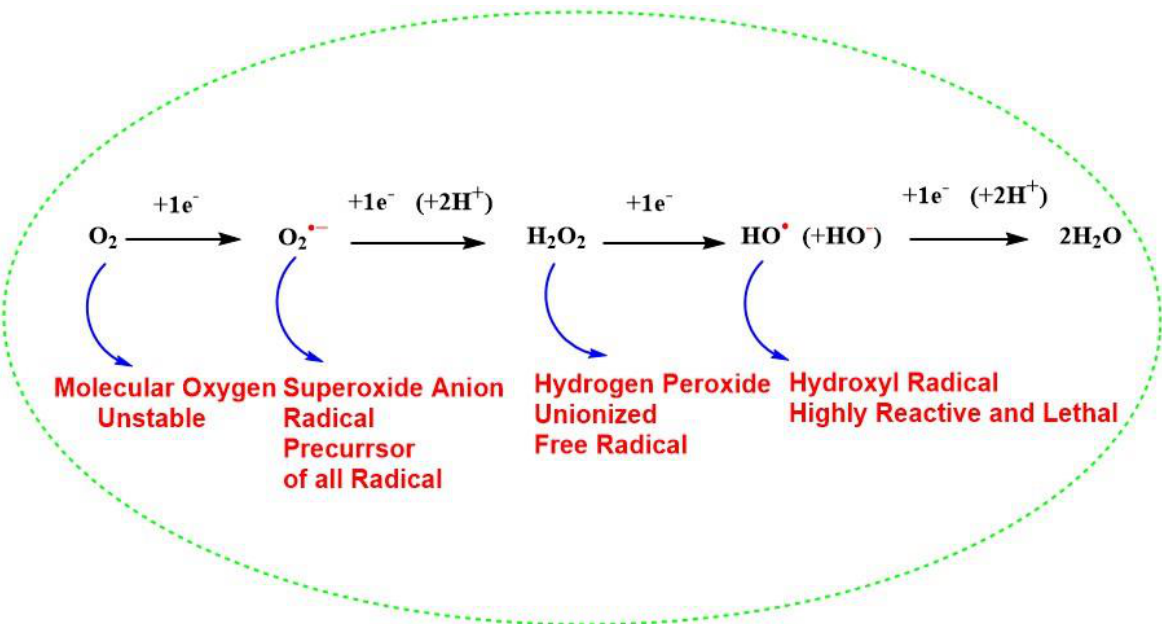
Figure 1. Successive four-electron reduction of molecular oxygen to generate water and different reactive oxygen species during cellular